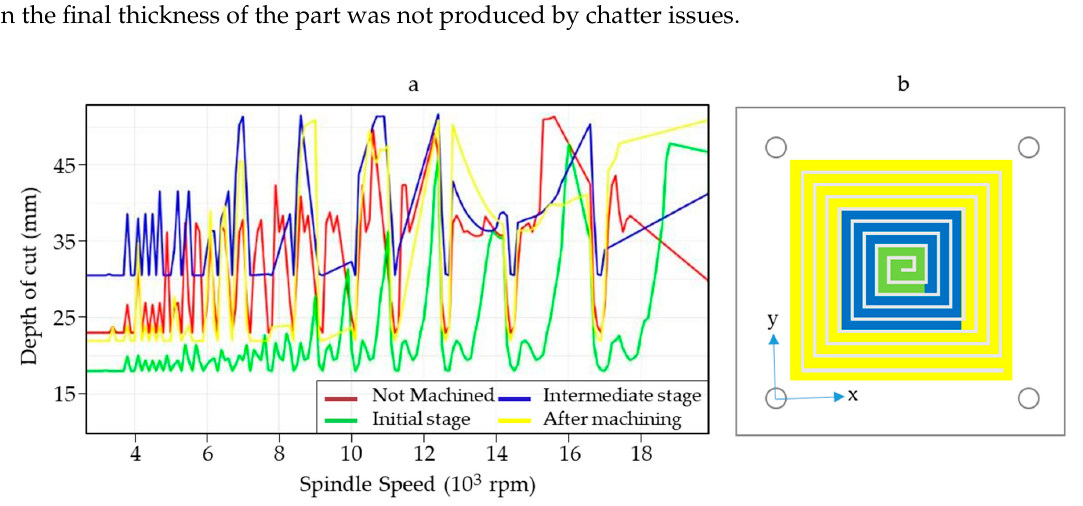
Figure 6. ( a ) Stability Lobe Diagrams (SLD) variation depending on the machining stage. Red line, before the machining; green line, in the first instants of the machining; blue line, intermediate stage; and yellow line, after the whole machining operation was performed. ( b ) Scheme of the areas of material removed in each stage with corresponding